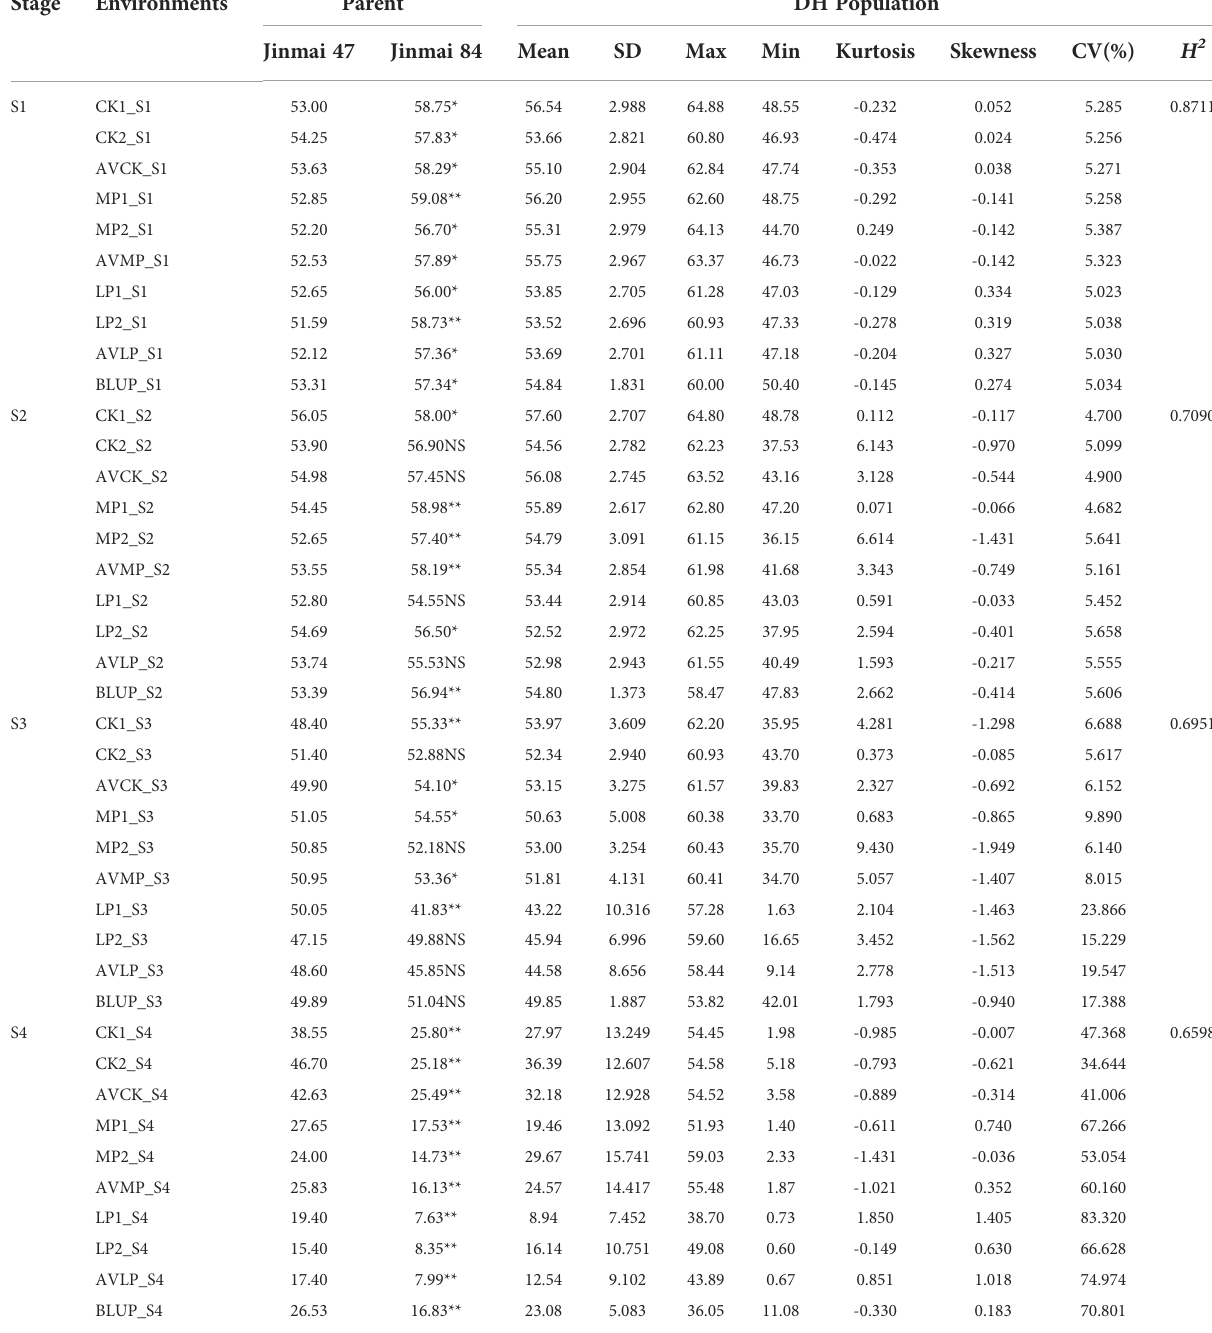
TABLE 1 The chlorophyll content of fl ag leaves in parents and DH population derived from Jinmai 47 × Jinmai 84 at four stages under three phosphorus conditions. Stage Environments